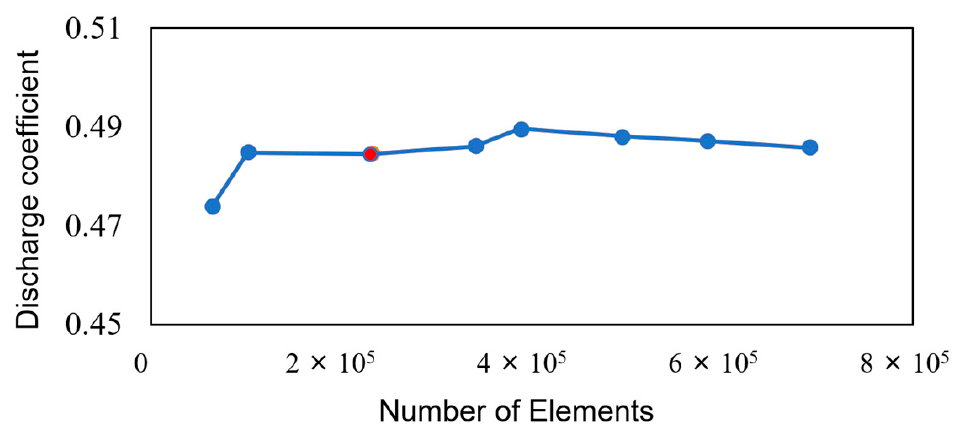
Analyses were performed to confirm the sensitivity to the number of grids in two dimensions. From approximately 64,000 to 700,000 grids, alignment grids were created using ANSYS ICEM. In addition, ANSYS Fluent v20.1 was used as the solver. Figure 3 shows that 100,000 and 230,000 grids indicated a 0.1% difference in the discharge coefficient, and approximately 230,000 and 700,000 grids indicated a 0.2% difference. Although no feasibility problems occurred even when the analysis was performed on 100,000 grids, approximately 230,000 grids were used to sufficiently express the flow field.